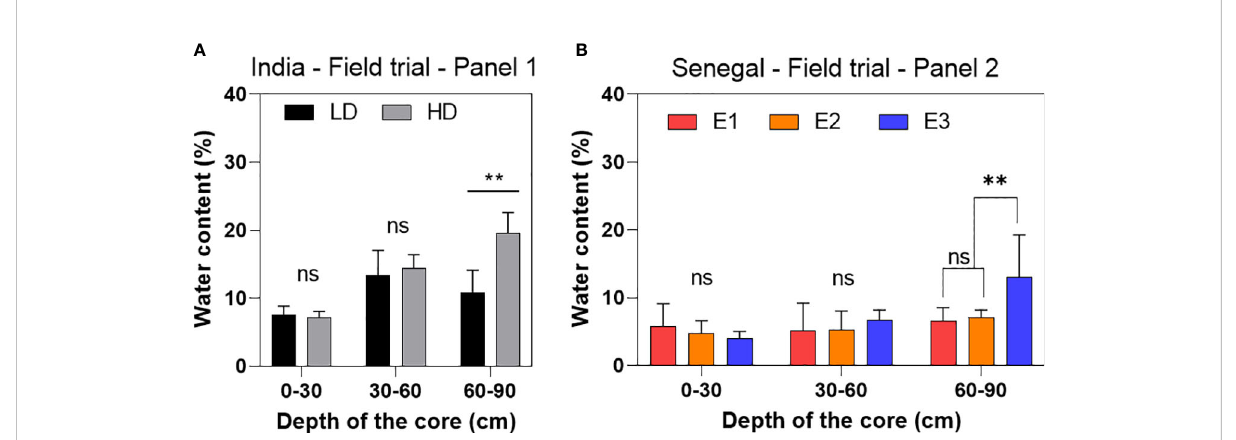
FIGURE 6 Percentage of soil moisture measured in three soil horizon pro fi les (0-30, 30-60 and 60-90cm) in the two density treatment (low density LD and high density HD) tested in India (A) and the three different density tested in Senegal (B) (E1, 3.2 plants/m 2 - E2, 6.4 plants/m 2 – E3, 12.8 plants/m 2 ). Results were obtained through soil cores performed in the fi eld immediately post-harvest. Means are average plus standard deviation of data collected in three plots for each of the density treatments. ns, non-signi fi cant. *p-value <